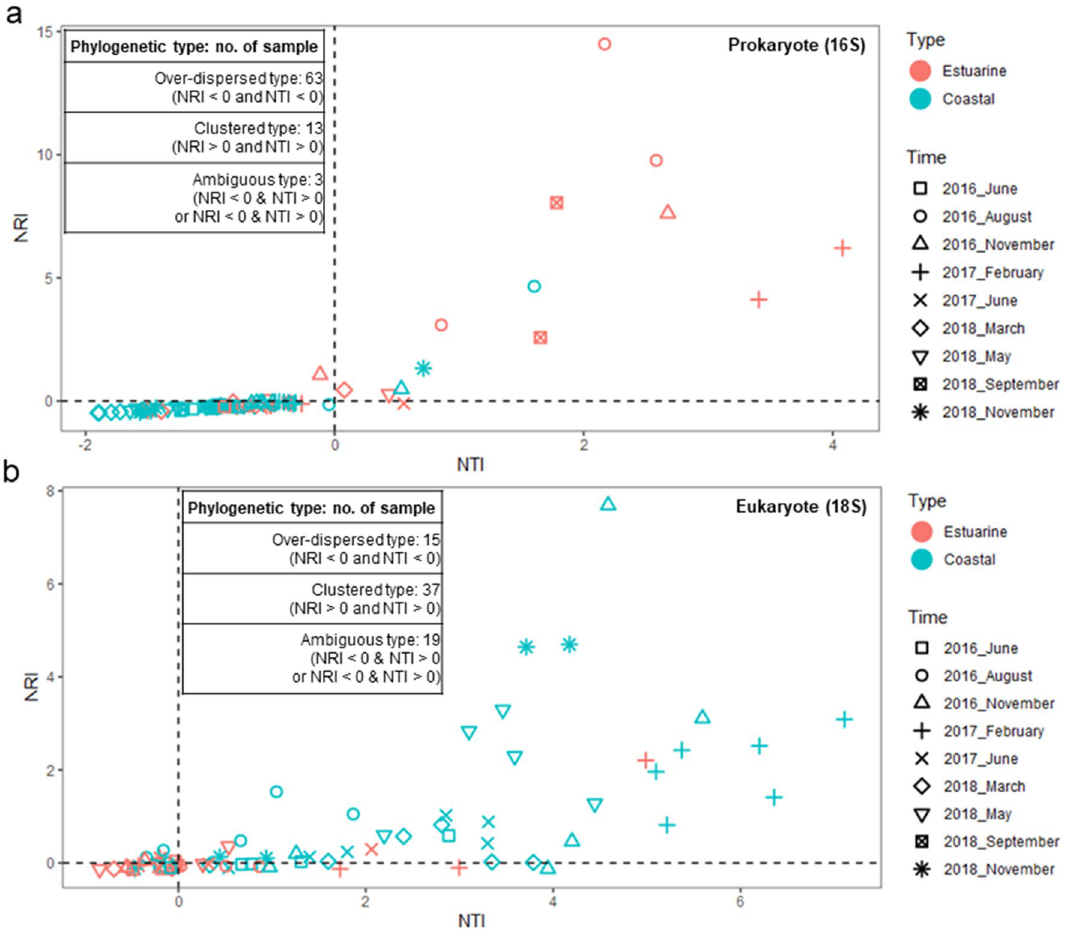
Figure 3. Phylogenetic turnover of microbial communities estimated using the Net Relatedness Index and Nearest Taxon Index. ( a ) Prokaryotic community and ( b ) eukaryotic